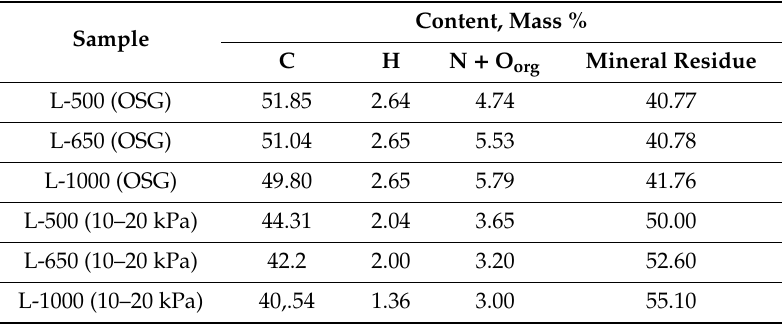
Table 1. Elemental composition of hydrolytic lignin carbonization products. Sample